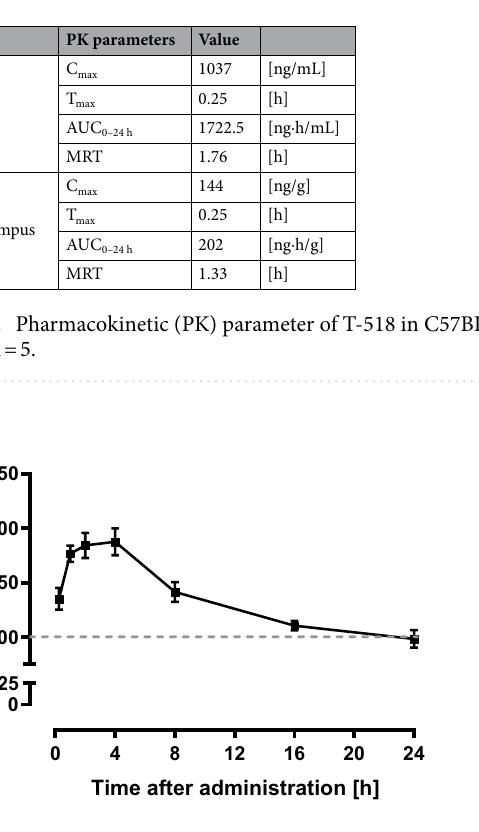
Figure 4. Time course study of pharmacodynamics of T-518. The compound was orally administered to 10-week-old male C57BL/6J mice at 3 mg/kg, and effect on tubulin acetylation in hippocampus was measured at 0.25, 1, 2, 4, 8, 16, and 24 h post-treatment. Data are expressed as mean ± SEM, n = 5. Statistical analysis was not performed.